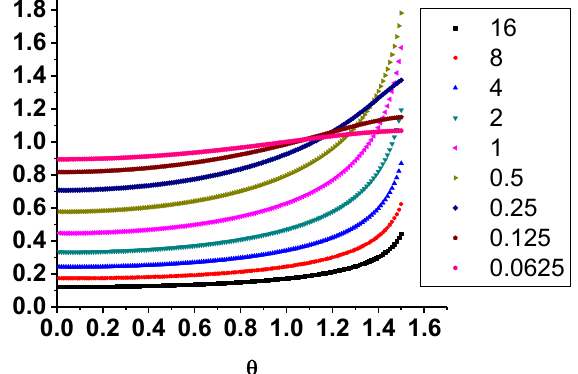
Figure 4. Film thickness evolution at different dimensionless time T .